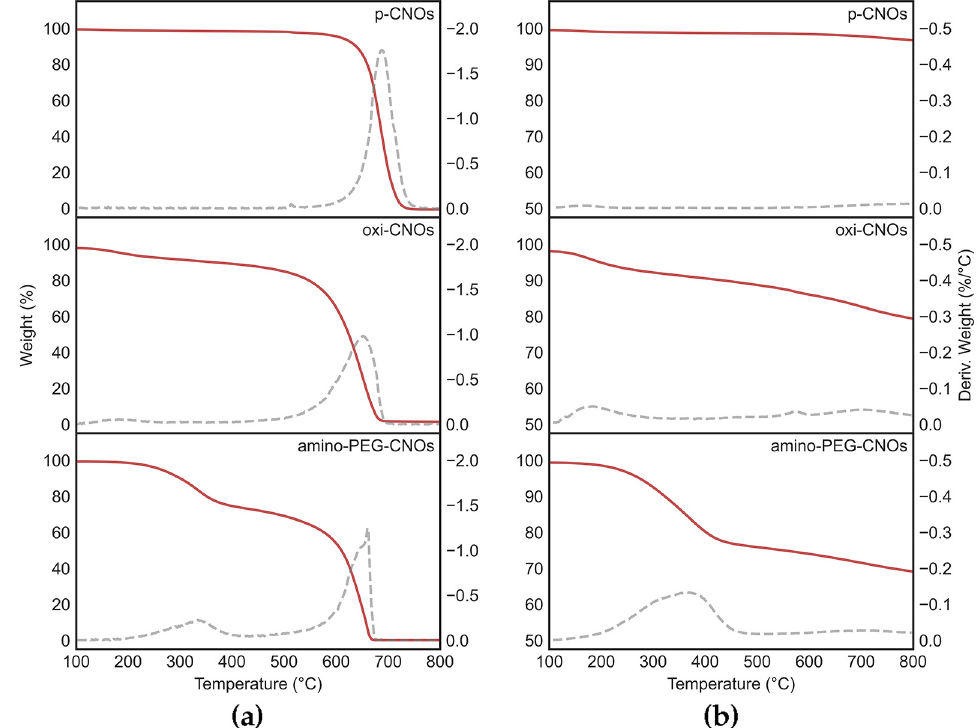
Figure 2. TGA data in ( a ) air and ( b ) nitrogen atmosphere of p-CNOs, oxi-CNOs, and amino-PEG-CNOs. Weight loss (red lines) and its first derivative over temperature (grey dashed lines) were consistent with the covalent functionalization of CNOs.